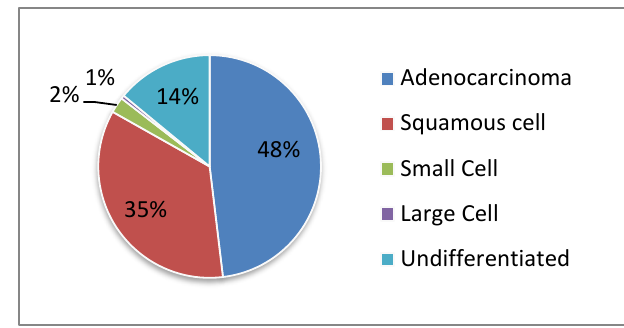
Figure 1. Histological types of Lung cancer.